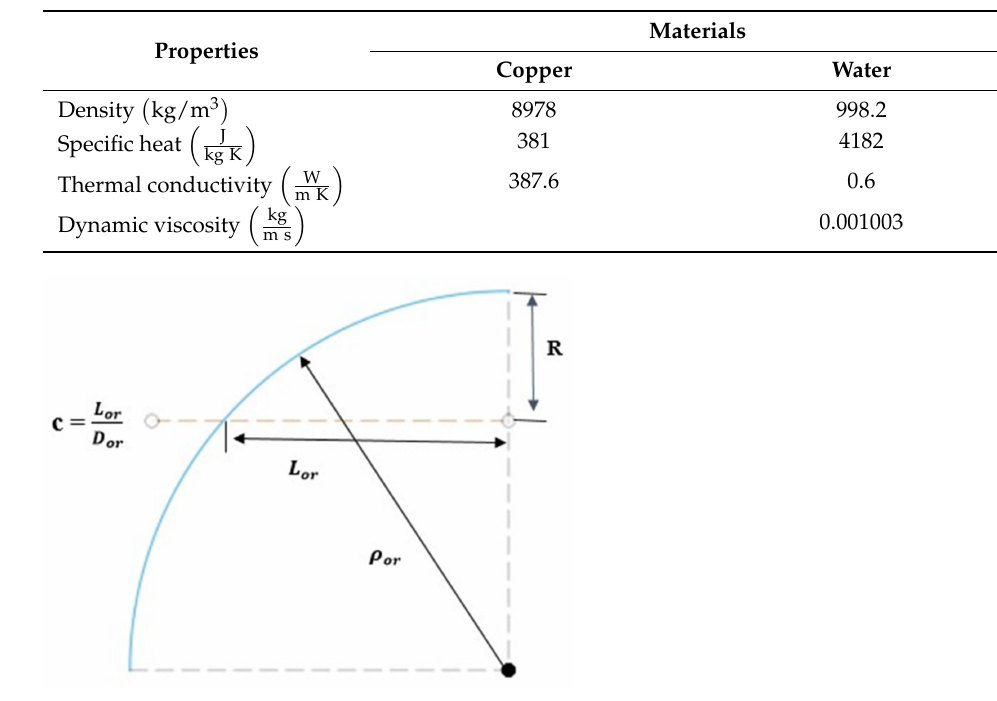
Figure 1. Description of MCHS computational domain. Table 1. Thermo-physical properties of copper and water (Constant thermo-physical properties of water mentioned in Table 1 are given at 293.15 K).